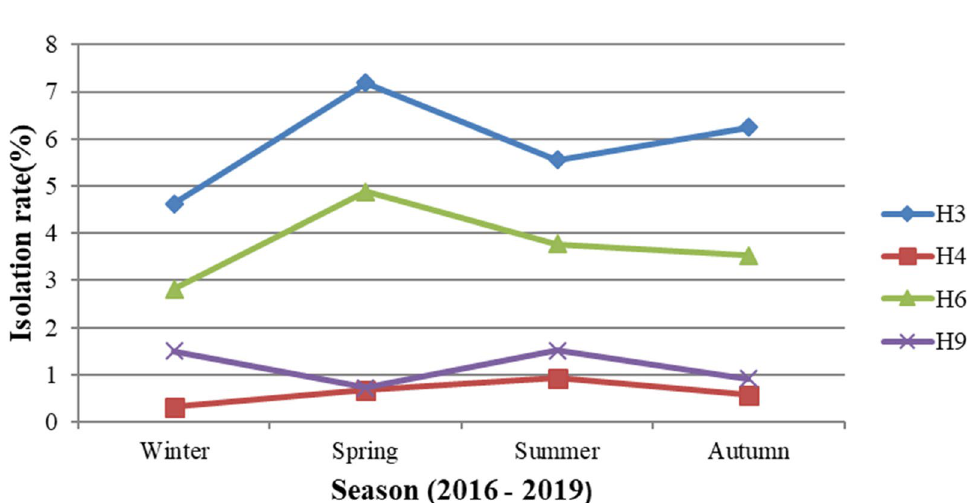
Figure 4. The isolation rates of the H3, H4, H6 and H9 subtypes in four